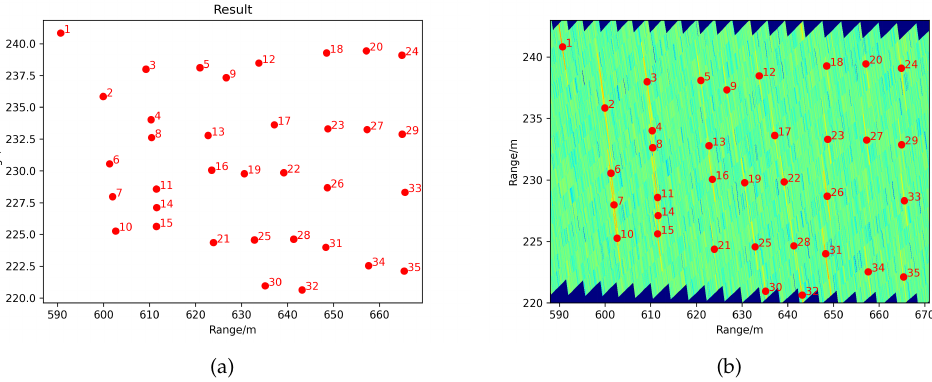
Figure 11. The detection results. ( a ) Taking one centroid point for each object. ( b ) The detection points together with amplification of local runway ROI.